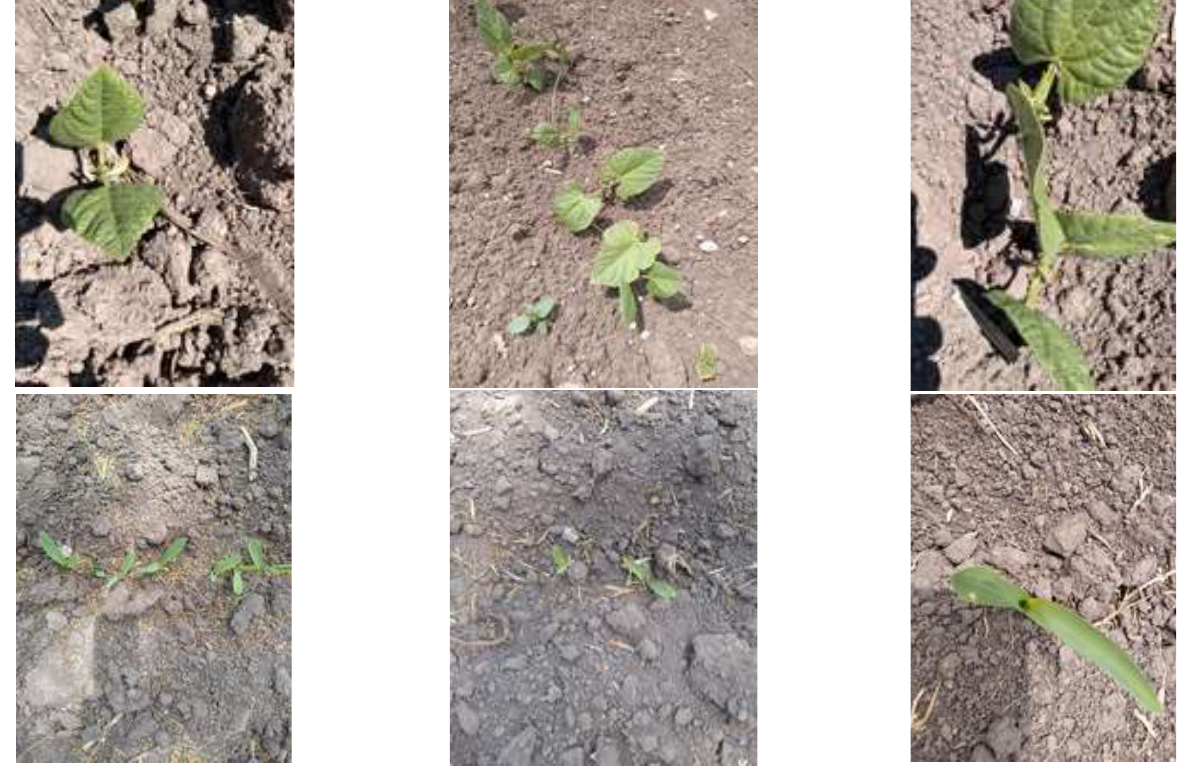
Figure 10. The threshold WDVI value for crop presence was determined based on the established